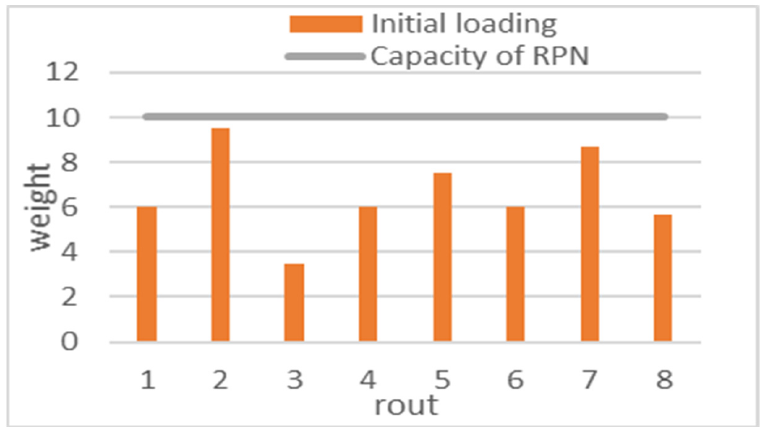
Figure 6. Compliance check for hard time windows.